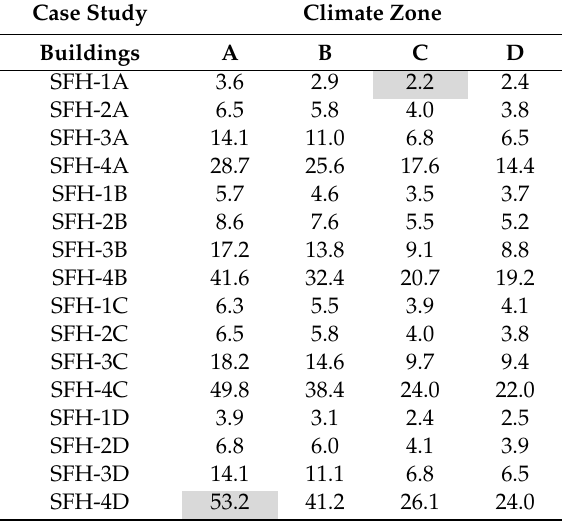
Table 4. Time (years) for the adapted annual operational energy use to match the initial EE for the 16 case studies in the four climate